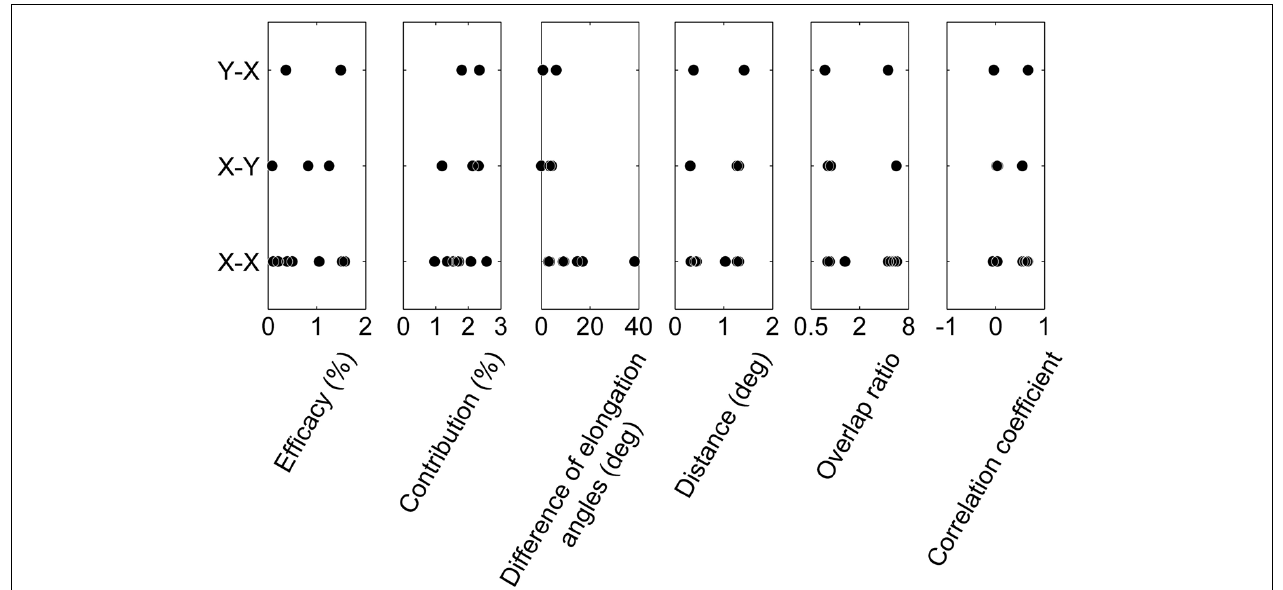
FIGURE 7 | Relationships between cell types and RF properties. From left to right, the relationships between the cell types in connection ( X–X, X–Y, and Y–X ) and efficacy, contribution, difference of elongation angles,